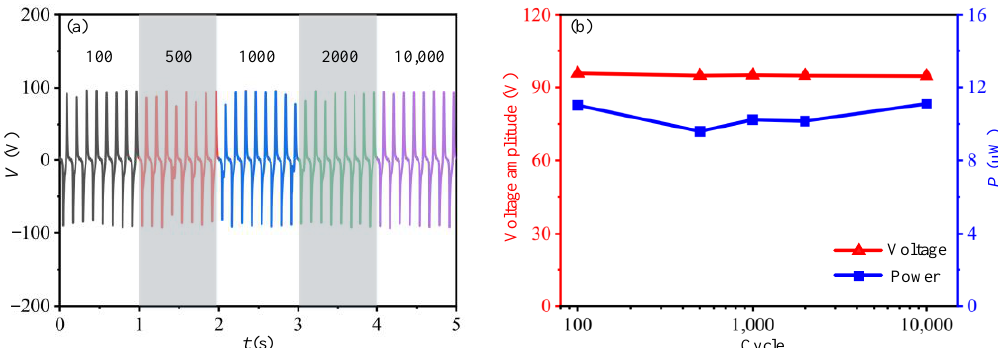
Figure 5. Output performance of TENG device after a certain period of operation. ( a ) is the time history results of the output current of TENG device after certain cycles of operation; ( b ) is influence of the loading cycles on the peak output current and average power of TENG device.